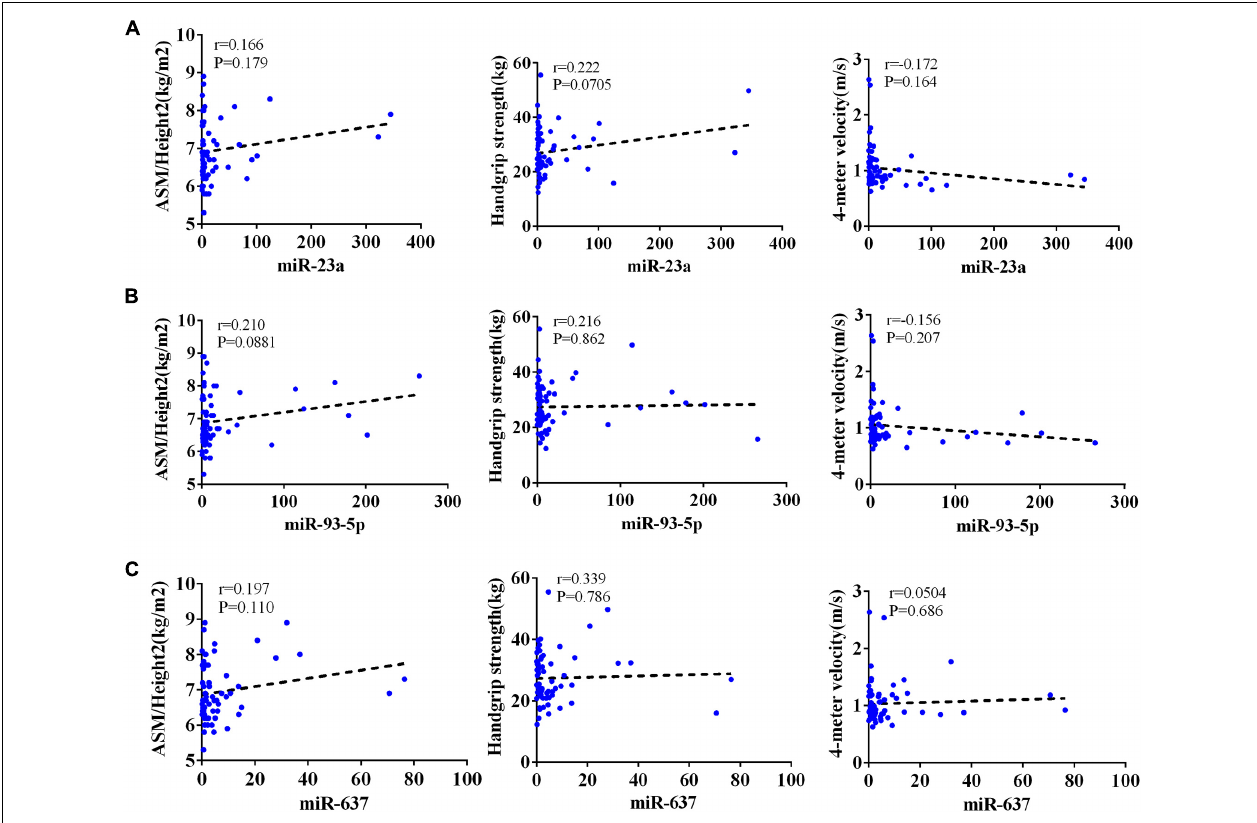
FIGURE 5 | Correlation analysis between the changes in (A) miR-23a-3p, (B) miR-93-5p, and (C) miR-637 and ASM/height 2 (kg/m 2 ), handgrip strength (kg), and 4-m velocity (m/s) in men. The correlation analysis of miR-23a-3p and miR-93-5p and miR-637 with these indicators in male subjects. Pearson’s method was used for correlation analyses; * P < 0.05; n =